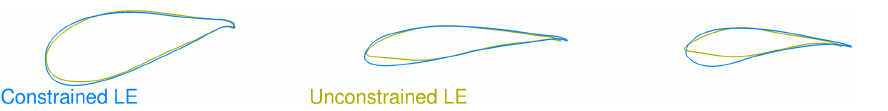
Figure 19. Comparison of airfoil profiles obtained from multipoint optimizations with and without LE geometric